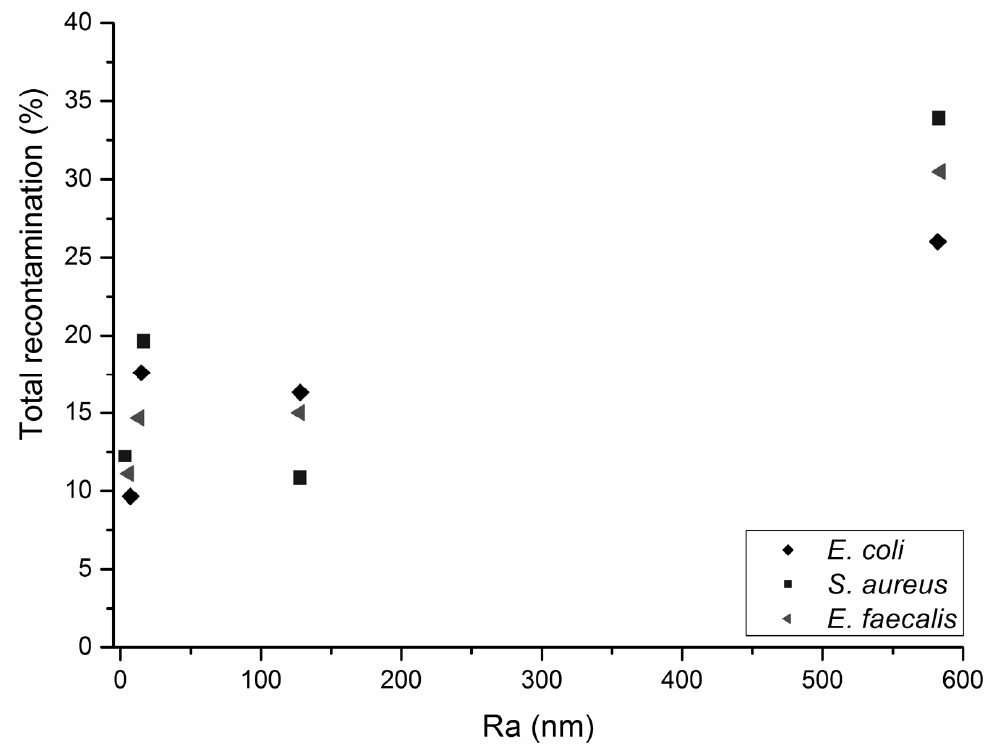
Figure 3. Total recontamination of surfaces by polypropylene nonwoven wipes versus average roughness (R a ) of the healthcare surface being wiped.